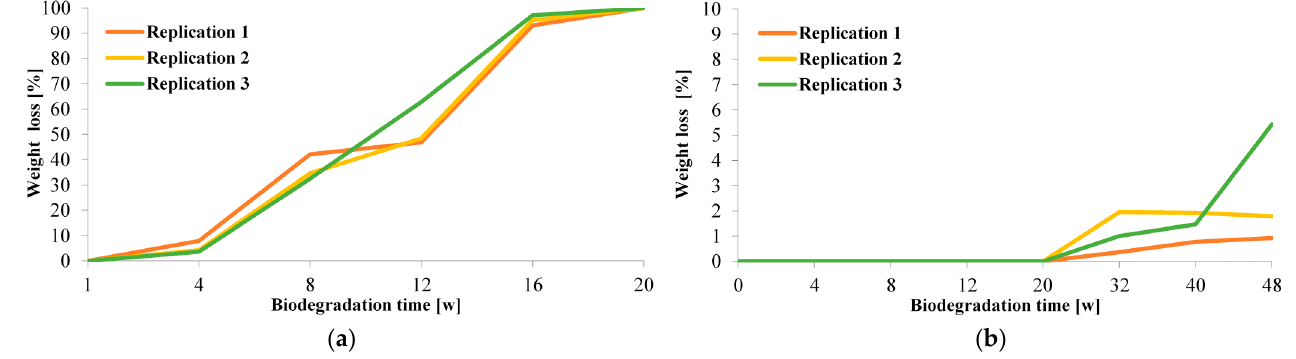
Figure 3. Weight loss of the CUT 2 stem support clips resulting from biodegradation during ( a ) 20-week industrial composting (at temperature of 58 ◦ C) and ( b ) 48-week home composting (at temperature of 30 ◦ C). Table 4. Disintegration of the CUT 2 stem support clips under industry (at temperature of 58 ◦ C) and home (at temperature of 30 ◦ C) composting conditions.